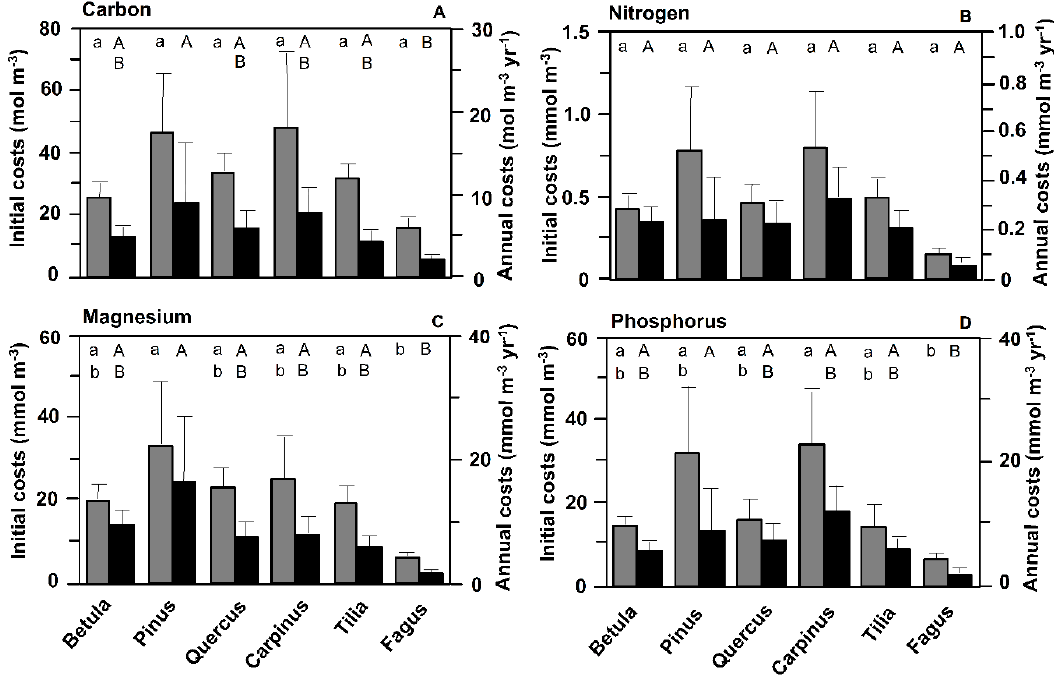
Figure 4. Costs of canopy space exploration and occupation in the sun crown of the six species, expressed as ‘initial costs’ (grey bars; the standing biomass of leaves/needles, twigs, and branches) and ‘annual costs’ (black bars; annual leaf/needle mass production) in terms of C, N, Mg, or P investment ( A – D ) needed to build the organs (means and standard deviation of each four harvested trees [ Fagus : N = 9 ]). Significantly di ff erent means between species are indicated by di ff erent small letters (initial costs) or capital letters (annual costs). For Pinus , only the production of current ‐ year needles is considered in the annual costs. In case of nitrogen, foliar leaching and uptake are not considered. The species are arranged according to their position in forest succession.